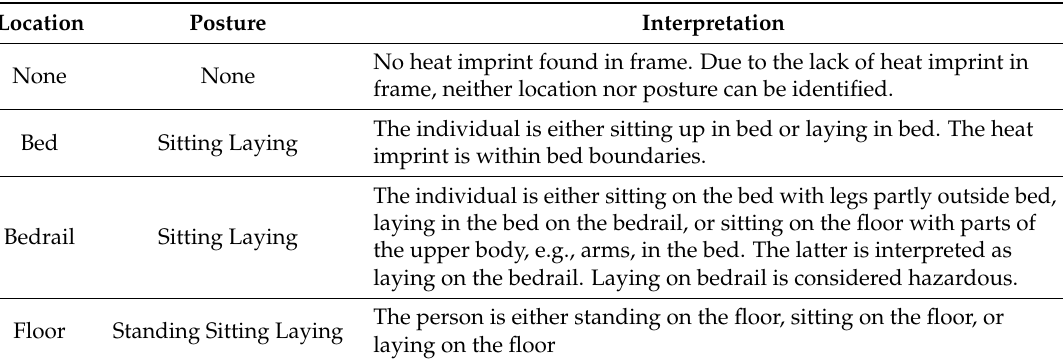
Table 3. Interpretation of location L f and posture PO f